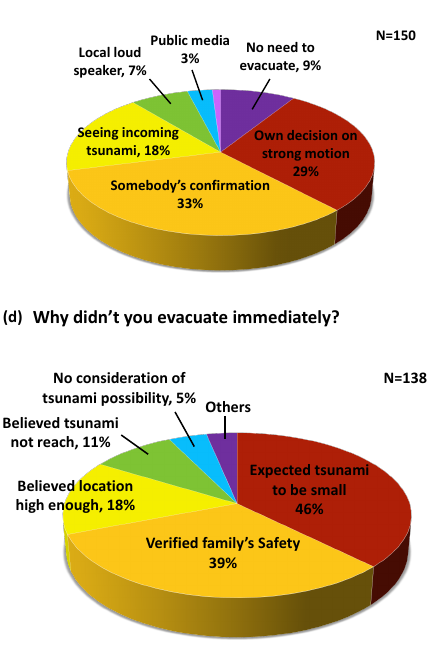
Fig. 4. Replies from the interviewers in response to the questions items. Hereafter the number in block brackets [ ] denotes the num- ber of a corresponding question item in Table 2. (a) [5], (b) [2], (c) [7], and (d) [6]. (d) Two or three replies from an interviewee are included, where the percentage was calculated with respect to the number of 103 interviewees replying. Hence, the total percentage of this case exceeds 100%. “N” in each panel shows the number of